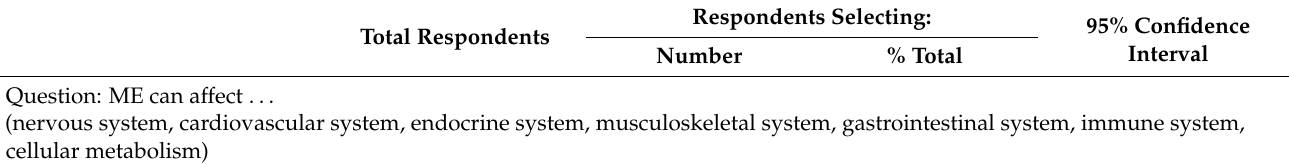
Table 9. The Impact of ME—Perceived extent of involvement of body